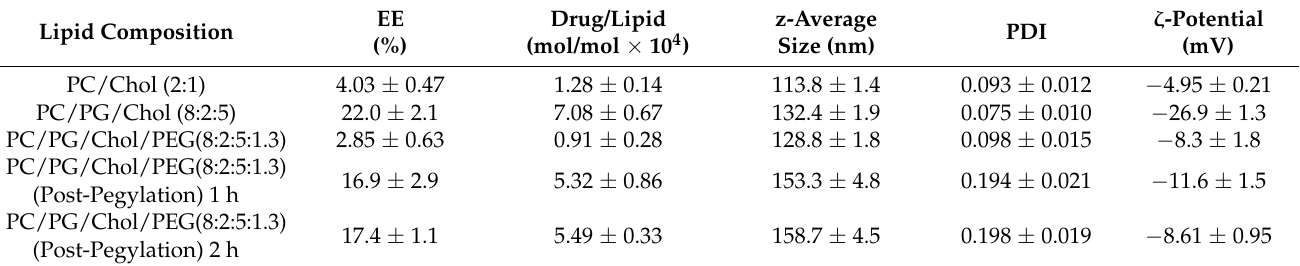
Table 1. RLX2 liposome physicochemical properties. Liposomes were prepared by the DRV method, and each value reported is the mean of at least three different samples; corresponding SD values are reported